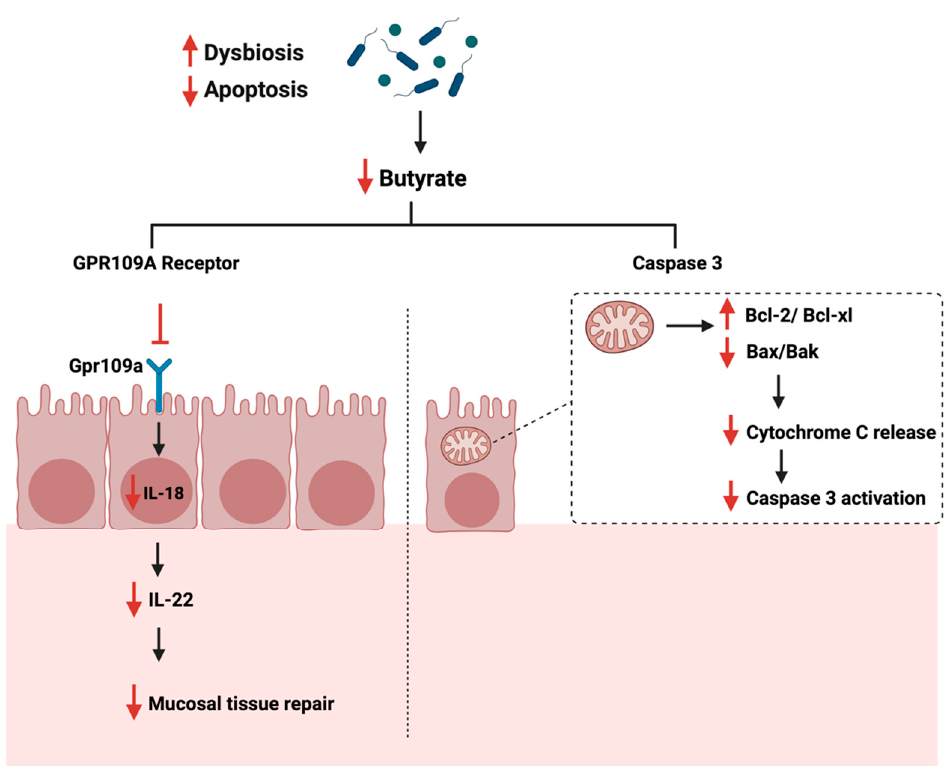
Figure 6. Illustrations of the role of short-chain fatty acids specifical butyrate on cellular apoptosis. The figure highlights the Gpr109a receptor and the pathways that lead to the reduction of mucosal tissue repair and Caspase 3 activation. “Created with BioRender.com”.